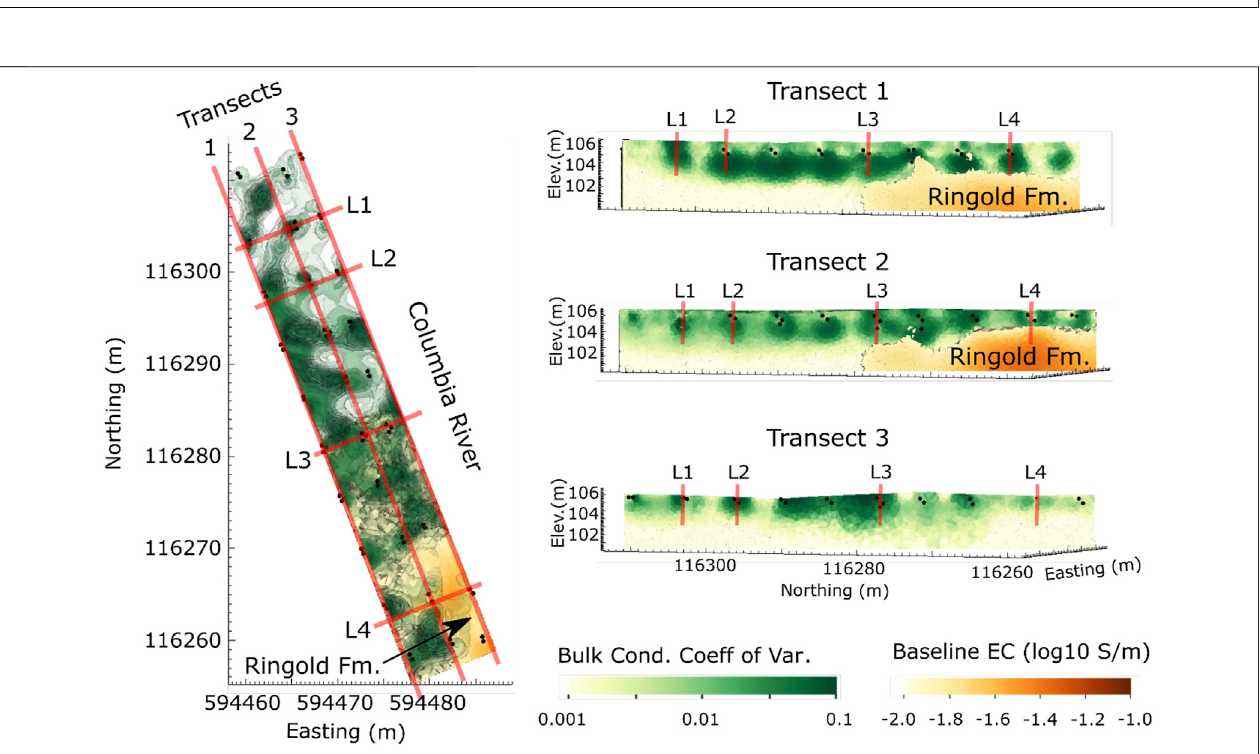
FIGURE9| CrosssectionsofbulkECtime-seriescoef fi cientofvariationalongthethreethermistor/electrodetransectssuggestshallowgroundwater/surfacewater interaction. Thermistor responses along lines L1 through L4 are shown in Figure 10 .